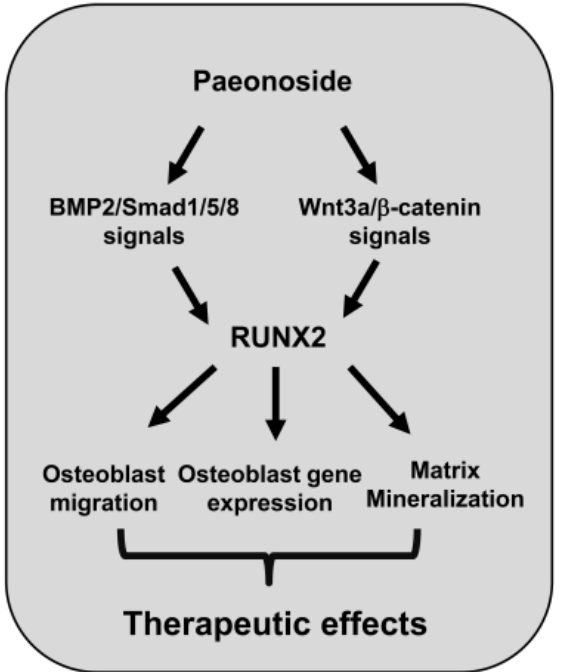
Figure 8. Schematic showing PASI-mediated osteoblast differentiation and mineralization.